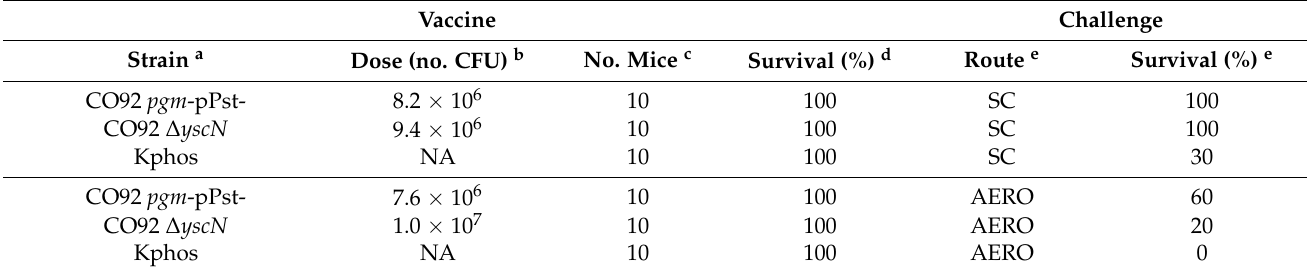
Table 4. Protection of CD-1 mice with live Y. pestis vaccine strains.